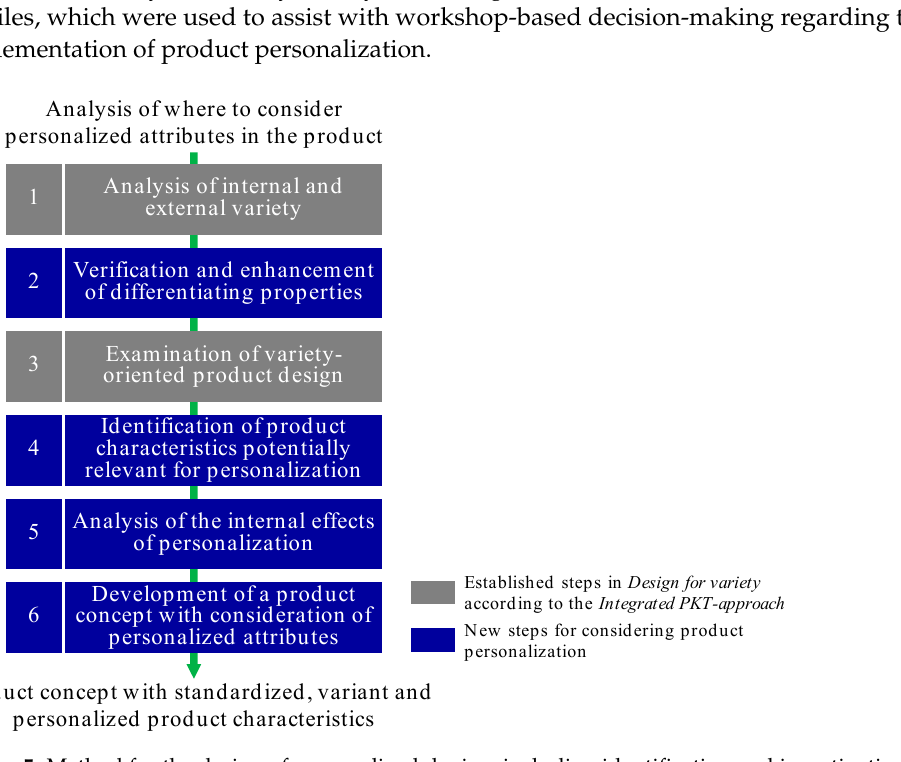
Figure 5. Method for the design of personalized devices including identification and investigation of product characteristics relevant to individualization as a means of dealing with the tradeoff between individual value and personalization workload.